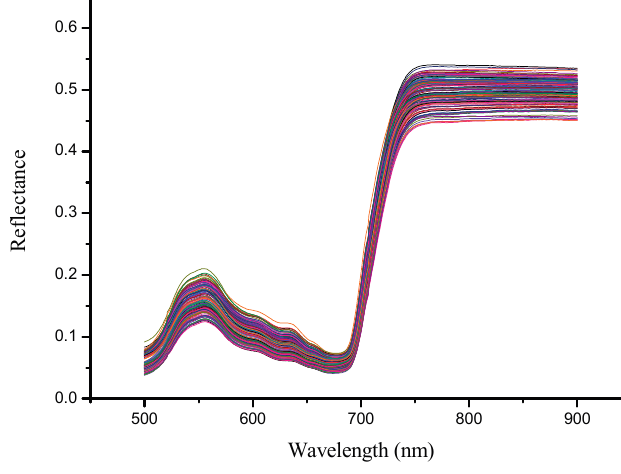
Figure 2. Raw spectra (500–900 nm) of rape leaves